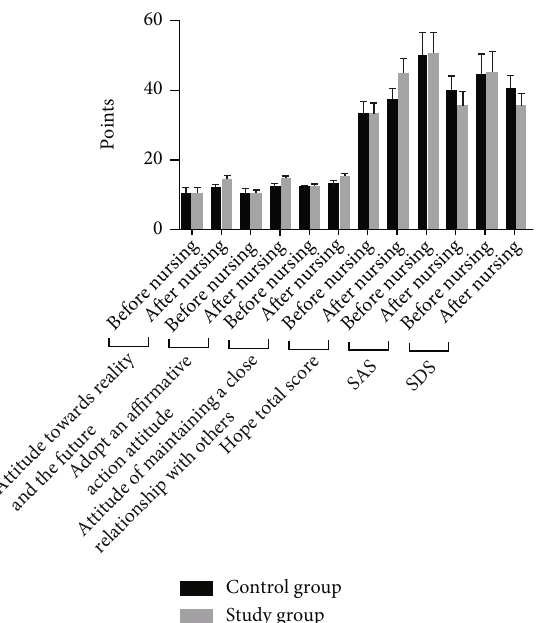
Figure 5: Histogram comparing the mood and hope scores of the two